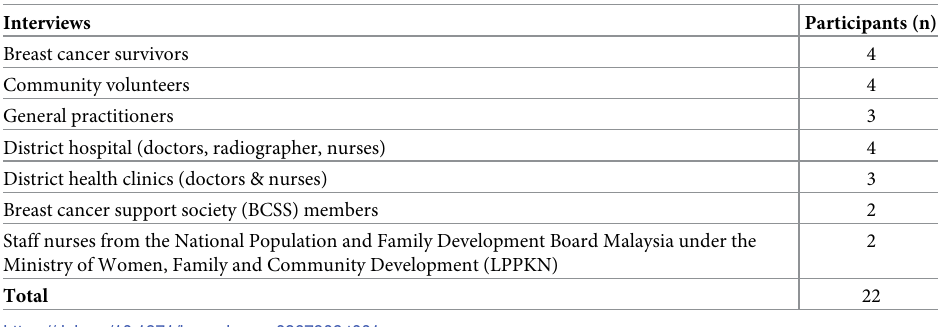
Table 1. Participation in individual